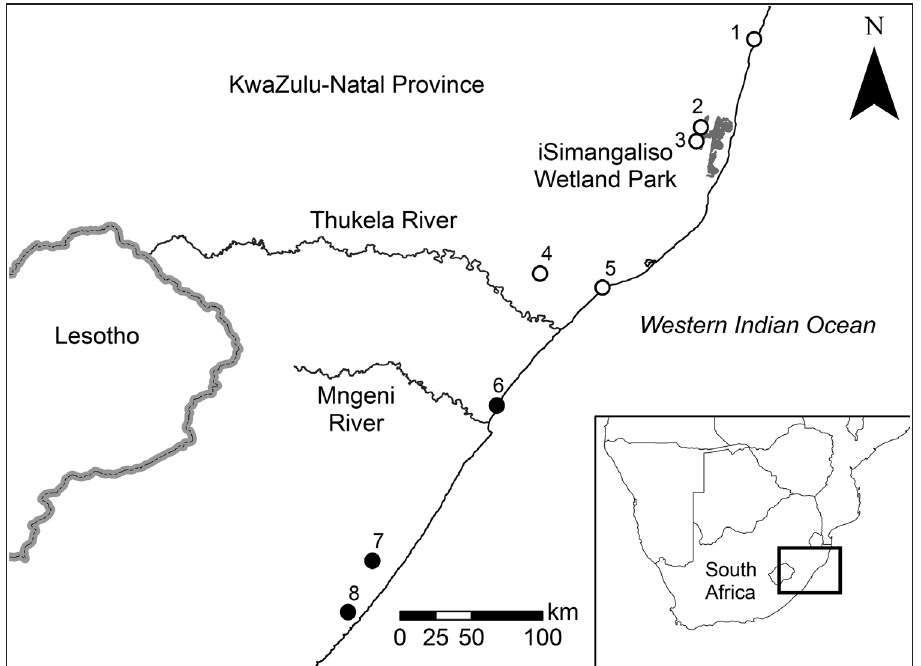
Figure 1. Sampling localities for the present study of Potamonautes in KwaZulu-Natal Province on the east of South Africa. The collection localities of P. danielsi sp. n. are indicated by black dots, while those of P. sidneyi are indicated by white open dots. Sites are indicated by numbers which correspond to locali- ties as follows: (Site 1) Lake Sibaya, (Site 2) Mpophomeni Stream, (Site 3) Hluhluwe, (Site 4) Entumeni, (Site 5) Siyayi, (Site 6) Mhlanga, (Site 7) Oribi Gorge and (Site 8) Mtamvuna. Map modified